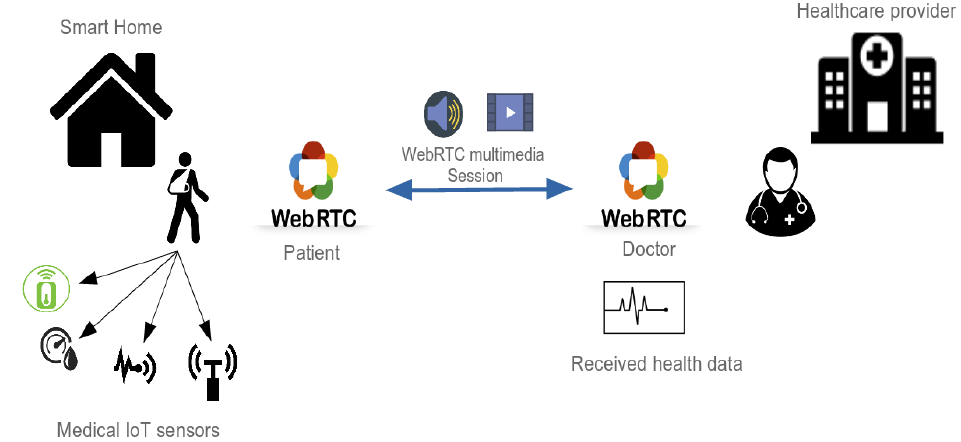
Figure 16. Remote medical consultation in the smart